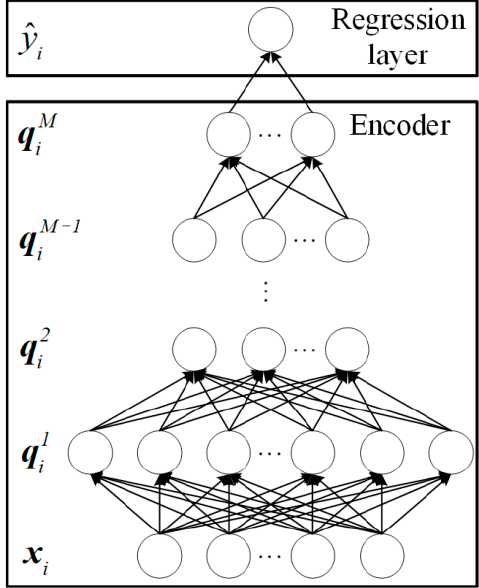
Figure 3. A deep neural network with 𝑀 hidden layers.